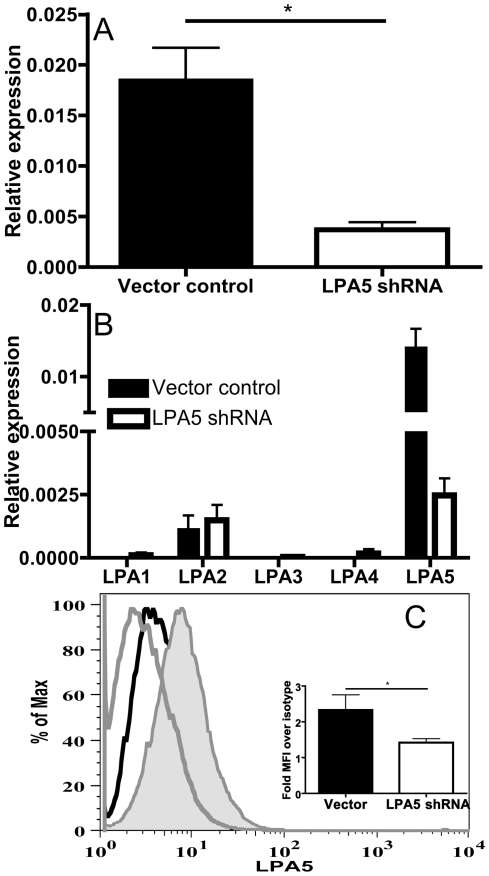
Impact of shRNA based silencing on LPA5 transcript and surface expression.(A) Transcript levels of LPA5 were determined 72 h post transduction with either control vector or LPA5 shRNA in four independent experiments. (Mean ± SD, N = 7, *P<0.05) (B) Transcript levels of a panel of LPARs were assessed to investigate possible off-target effects of transduction with vector (black bars) or LPA5 shRNA (white bars). (C) Surface expression of LPA5 after transduction with empty vector (black tracing) or LPA5 shRNA (filled, black tracing) compared to isotype control (grey tracing). The quantified reduction in MFI, determined in three independent experiments, is shown in inset (Mean ± SD, N = 5, *P<0.05).